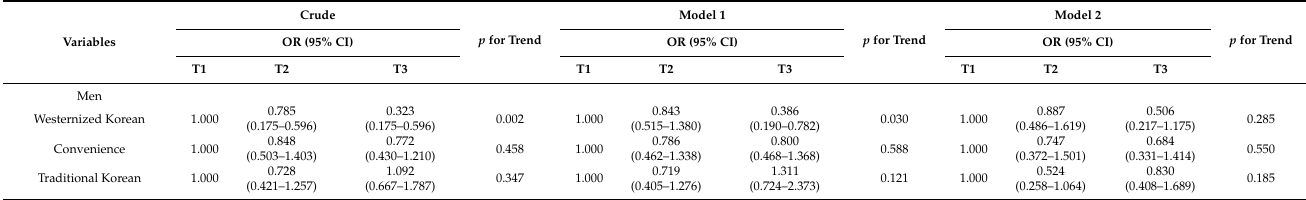
Table 4. Odds ratios for LGS according to tertiles of dietary